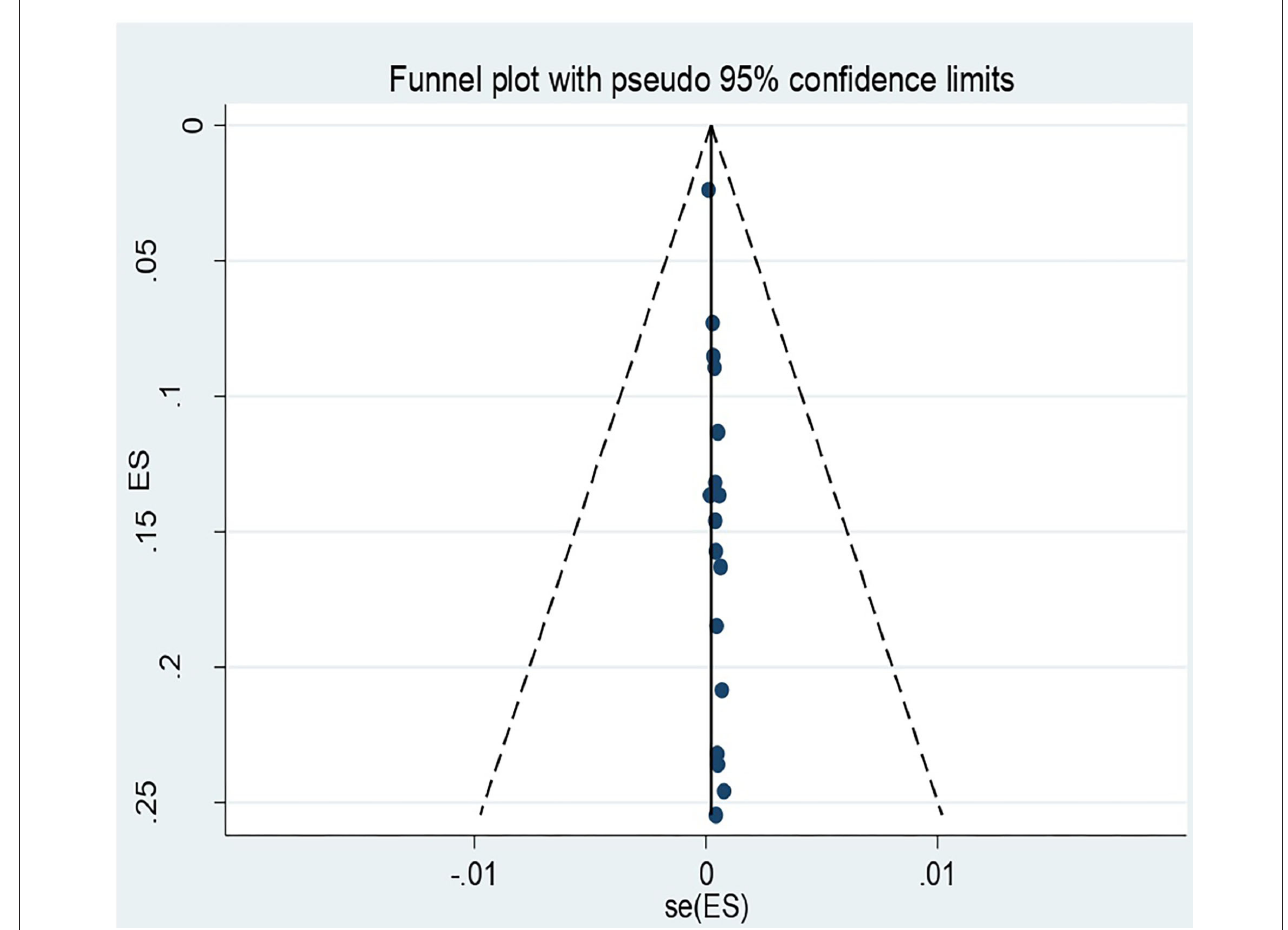
FIGURE 4 | Funnel plot for recto vaginal colonization of Group B streptococcus among pregnant women